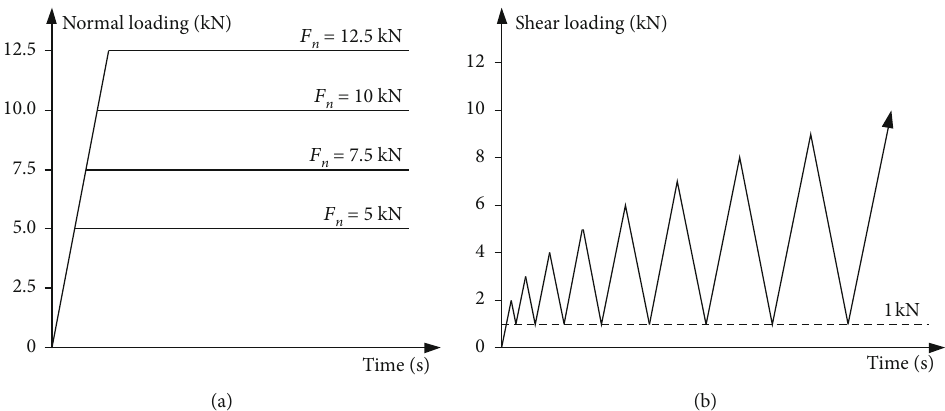
Figure 3: The designed loading path under CNL condition. (a) The set normal force of 5kN, 7.5kN, 10 kN, 12.5 kN. (b) Multilevel cyclic shear loading